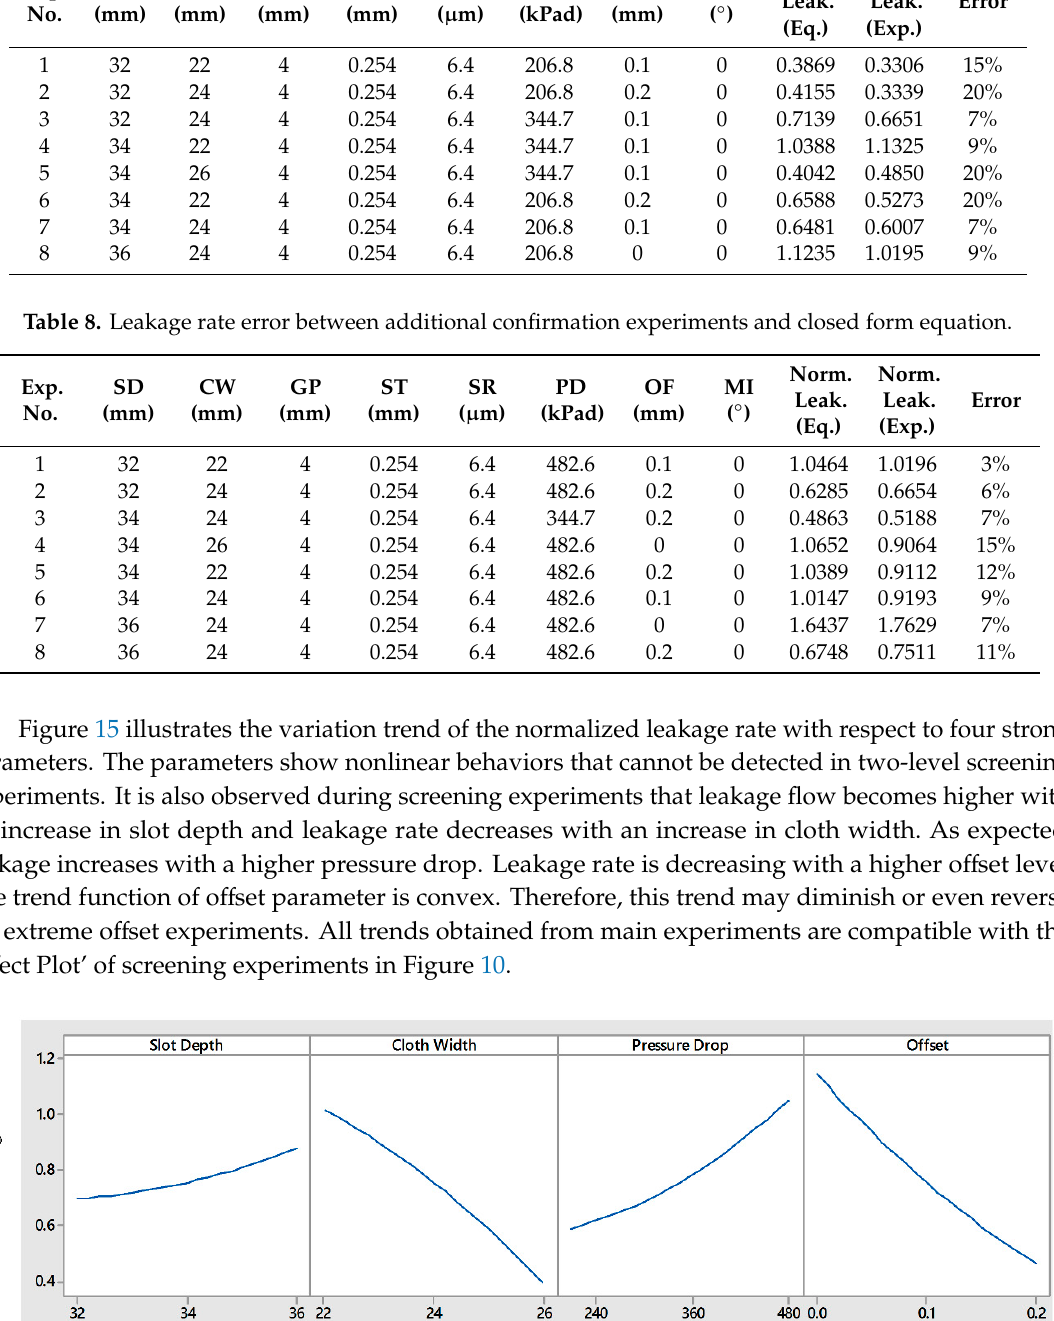
Table 7. Leakage rate error between confirmation experiments and closed form equation. Exp.